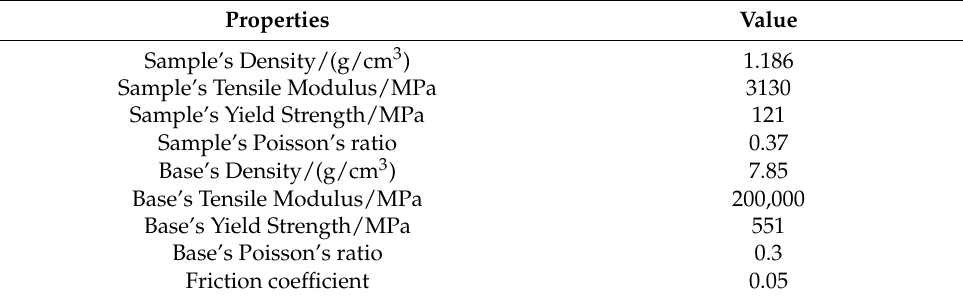
Table 3. Parameters for finite element simulation.